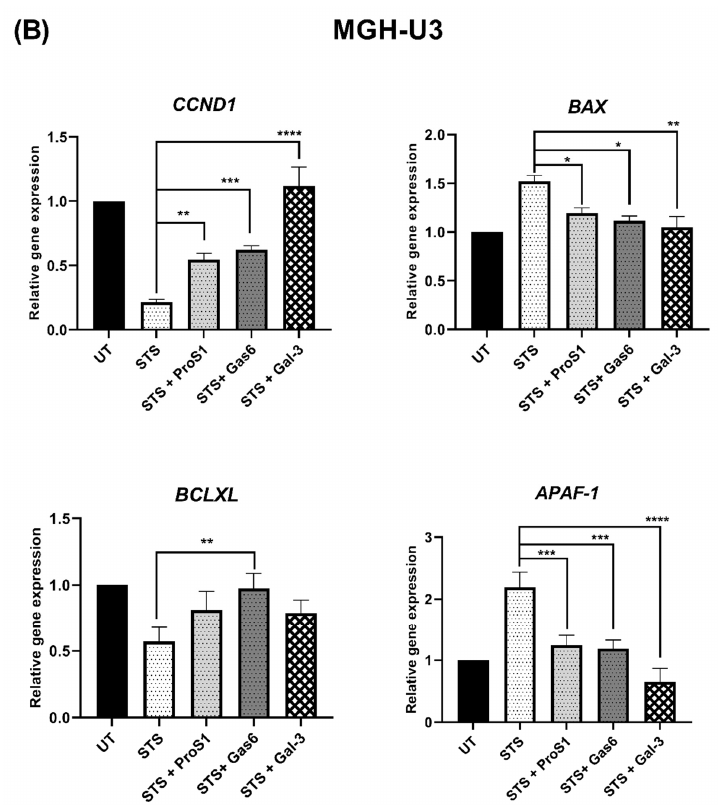
Figure 7. Quantitative RT-PCR analysis of effects of Gal-3 and TAM ligands on the expression of genes regulating apoptosis ( BAX , BCLXL , APAF-1 ) and cell cycle progression ( CCND1 , CDKN2A ) in SCC-25 ( A ) and MGH-U3 ( B ) cancer cells. Cells were treated for 20 h with staurosporine (STS; 0.1 μ M), with co-incubation with Gas6 (5.7 nM), ProS1 (7.5 nM) or Gal-3 (0.2 μ M) added 2 h previously. Relative gene expression is represented as fold change, (2 −ΔΔ Ct ) is the normalised gene expression (2 - Δ Ct ) in the treated samples divided by the normalised gene expression (2 −Δ Ct ) in the control sample (untreated; UT). Relative gene expression in each sample was normalised against the housekeeping gene GAPDH . Data are the mean ± SEM and underwent ANOVA with Tukey’s multiple comparison post-hoc analysis; **** p < 0.0001, *** p < 0.001, ** p < 0.01, * p < 0.05 versus STS-treated sample ( n = 3 experiments).